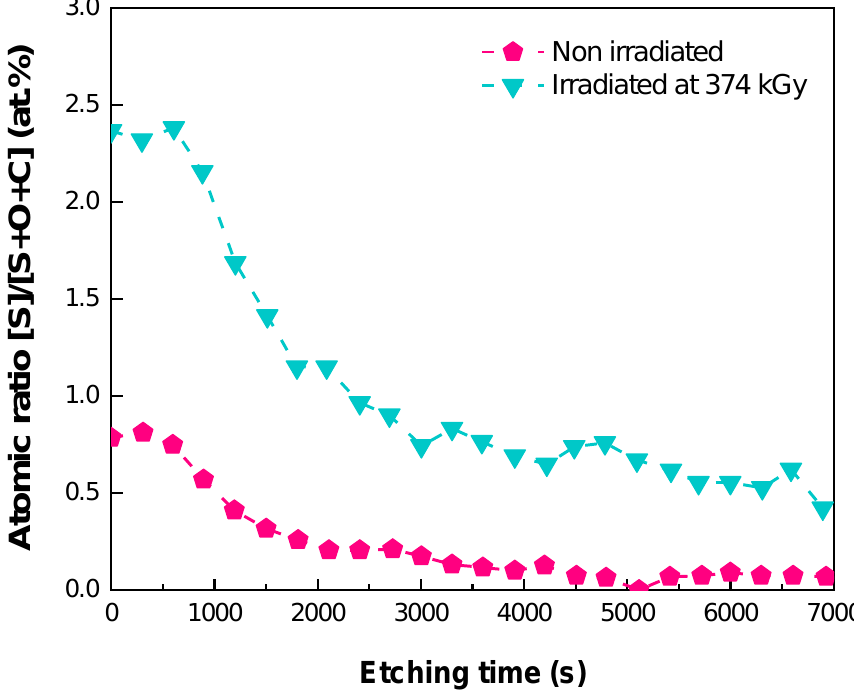
Figure 5. Sulphur relative concentration evolution for XLPE M4(Irg1076-IrgPS802) at two doses (0 and 374 kGy) and as a function of the etching time, i.e., of depth.